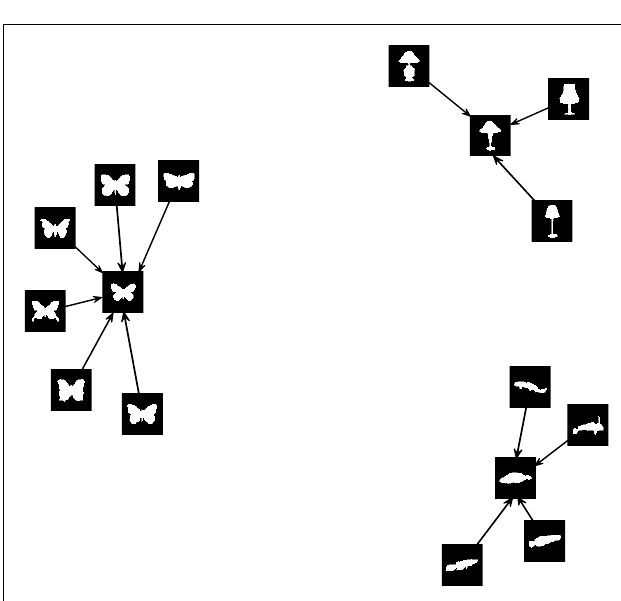
Figure 6. Network of the binary images where each image is connected to one exemplar. This directed graph exhibits three connected components forming three clusters coinciding with the content of